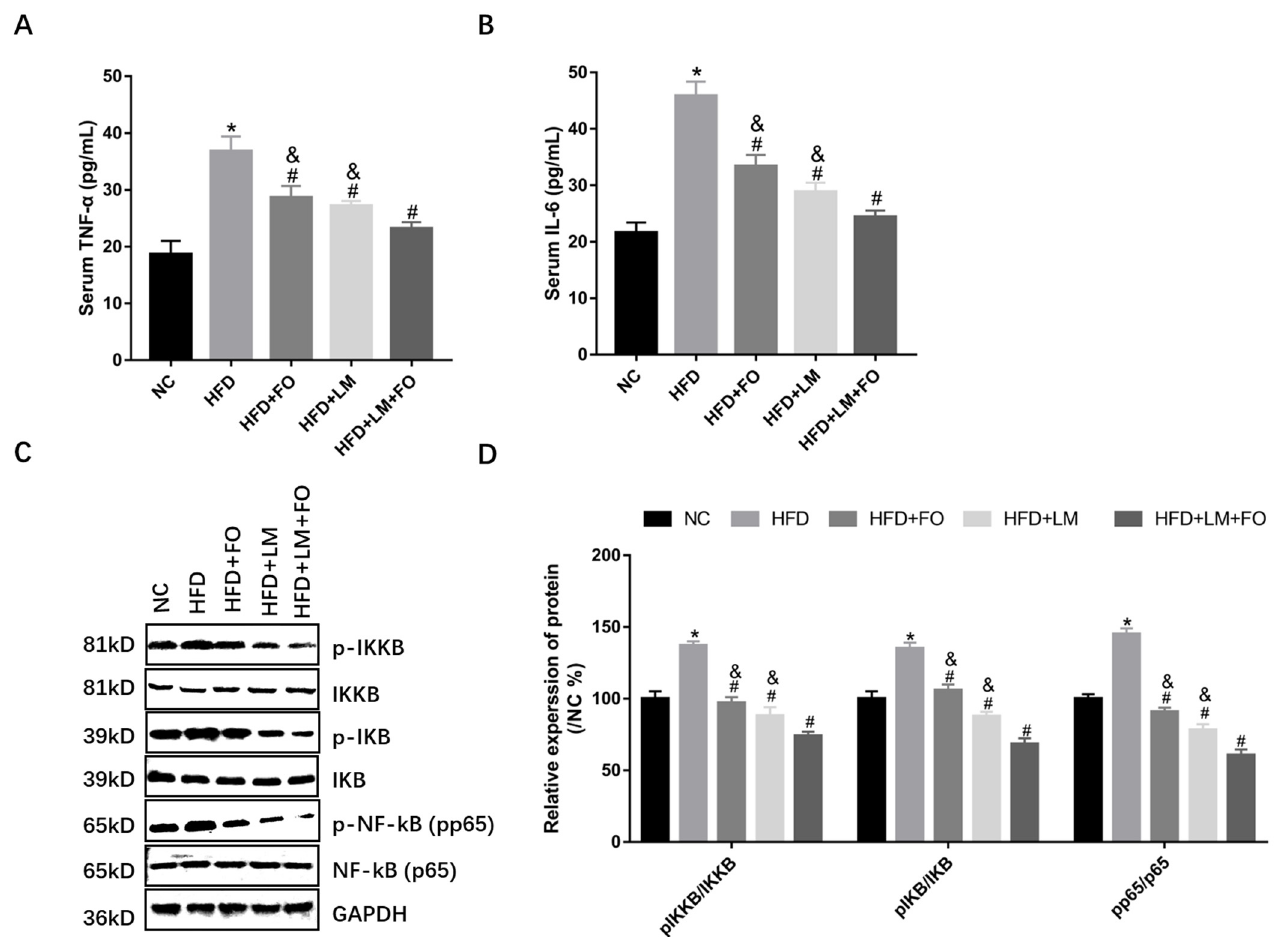
Figure 5. Effects of FO and LM on liver inflammation in HFD mice. The levels of ( A ) TNF- α and ( B ) IL-6 in serum were determined using ELISA, as described in the text. ( C ) Protein was detected by Western blot for the proteins of interest, including p -IKKB, IKKB, p -IKB, IKB, p -NF-kB (pp65), and NF-kB (p65). GAPDH was used as a reference protein. ( D ) Relative expression of p -IKKB/IKKB, p -IKB/IKB, and p -NF-kB (pp65)/NF-kB (p65) were calculated by ImageJ. Data are presented as means ± SD ( n = 3). * p < 0.05 vs. NC; # p < 0.05 vs. HFD; & p < 0.05 vs. LM + FO.